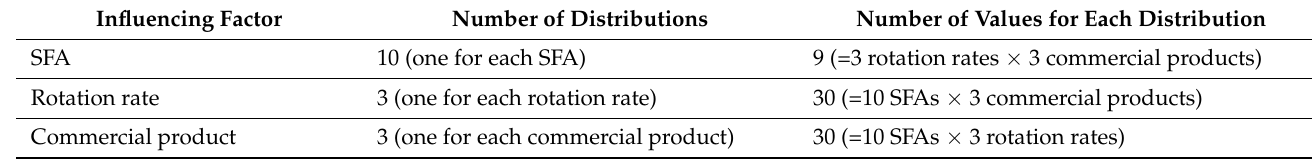
Table 2. Statistical analysis plan to evaluate the influence of SFAs, rotation rate, and commercial product on the errors. Influencing Factor Number of Distributions Number of Values for Each